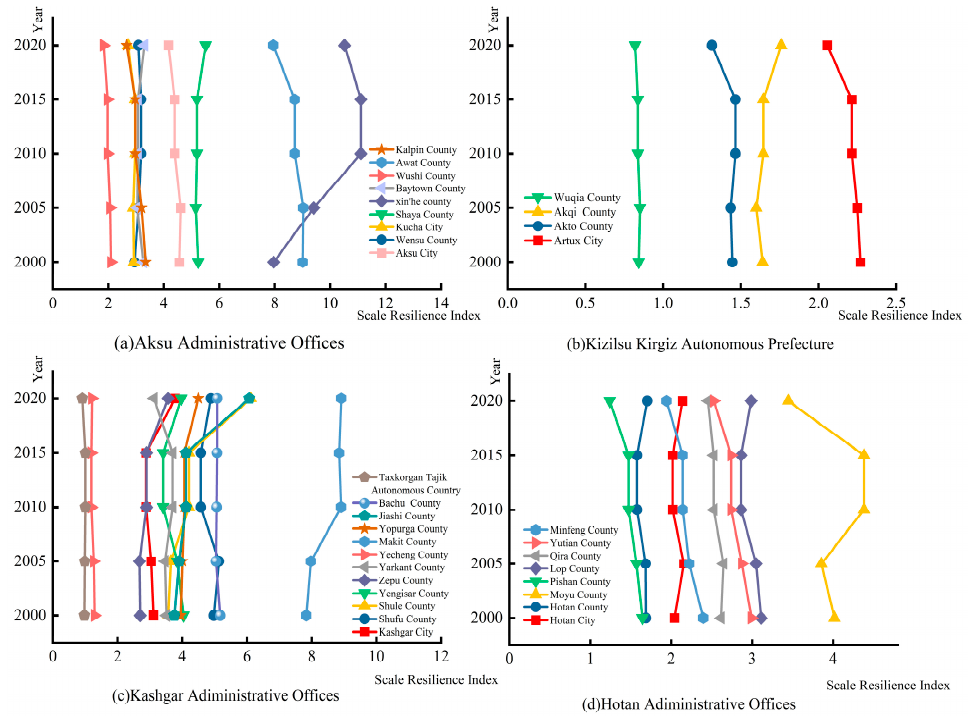
Figure 4. ( a ) Scale resilience index of Aksu Administrative Offices from 2000 to 2020. ( b ) Scale resilience index of Kizilsu Kirgiz Autonomous Prefecture from 2000 to 2020. ( c ) Scale resilience index of Kashgar Administrative Offices from 2000 to 2020. ( d ) Scale resilience index of Hotan Administrative Offices from 2000 to 2020.